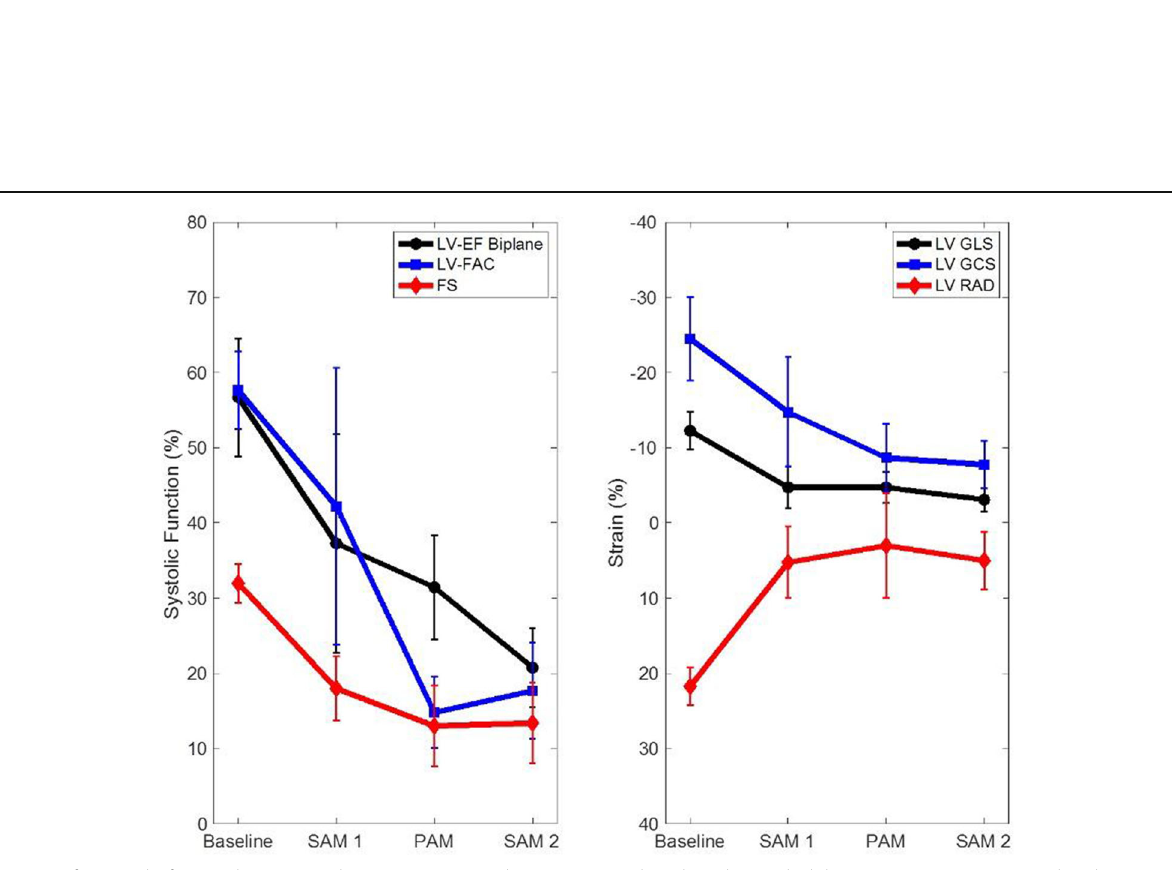
Fig. 3 Left ventricular functional assessment showing A EF, FAC, and FS; B strain. Error bars show the standard deviation. SAM, pump-supported working mode; PAM, passive afterload working mode. LV, left ventricular; EF, ejection fraction; FAC, fractional area change; GLS, global longitudinal strain; GCS, global circumferential strain; RAD, radial strain; FS, fractional